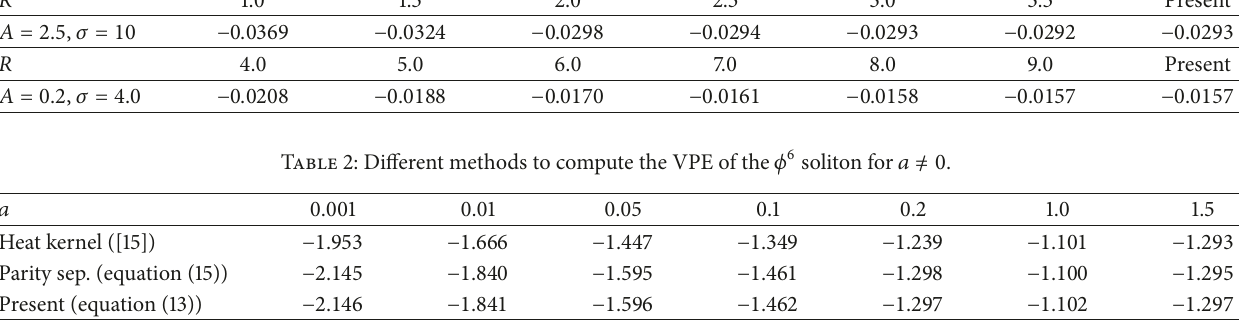
Table 1: The 𝑅 dependent data are half the VPE for the symmetrized potential, (31) computed from (15). The data in the column “ present ” list the results obtained from (13) for the original potential (see (30)).